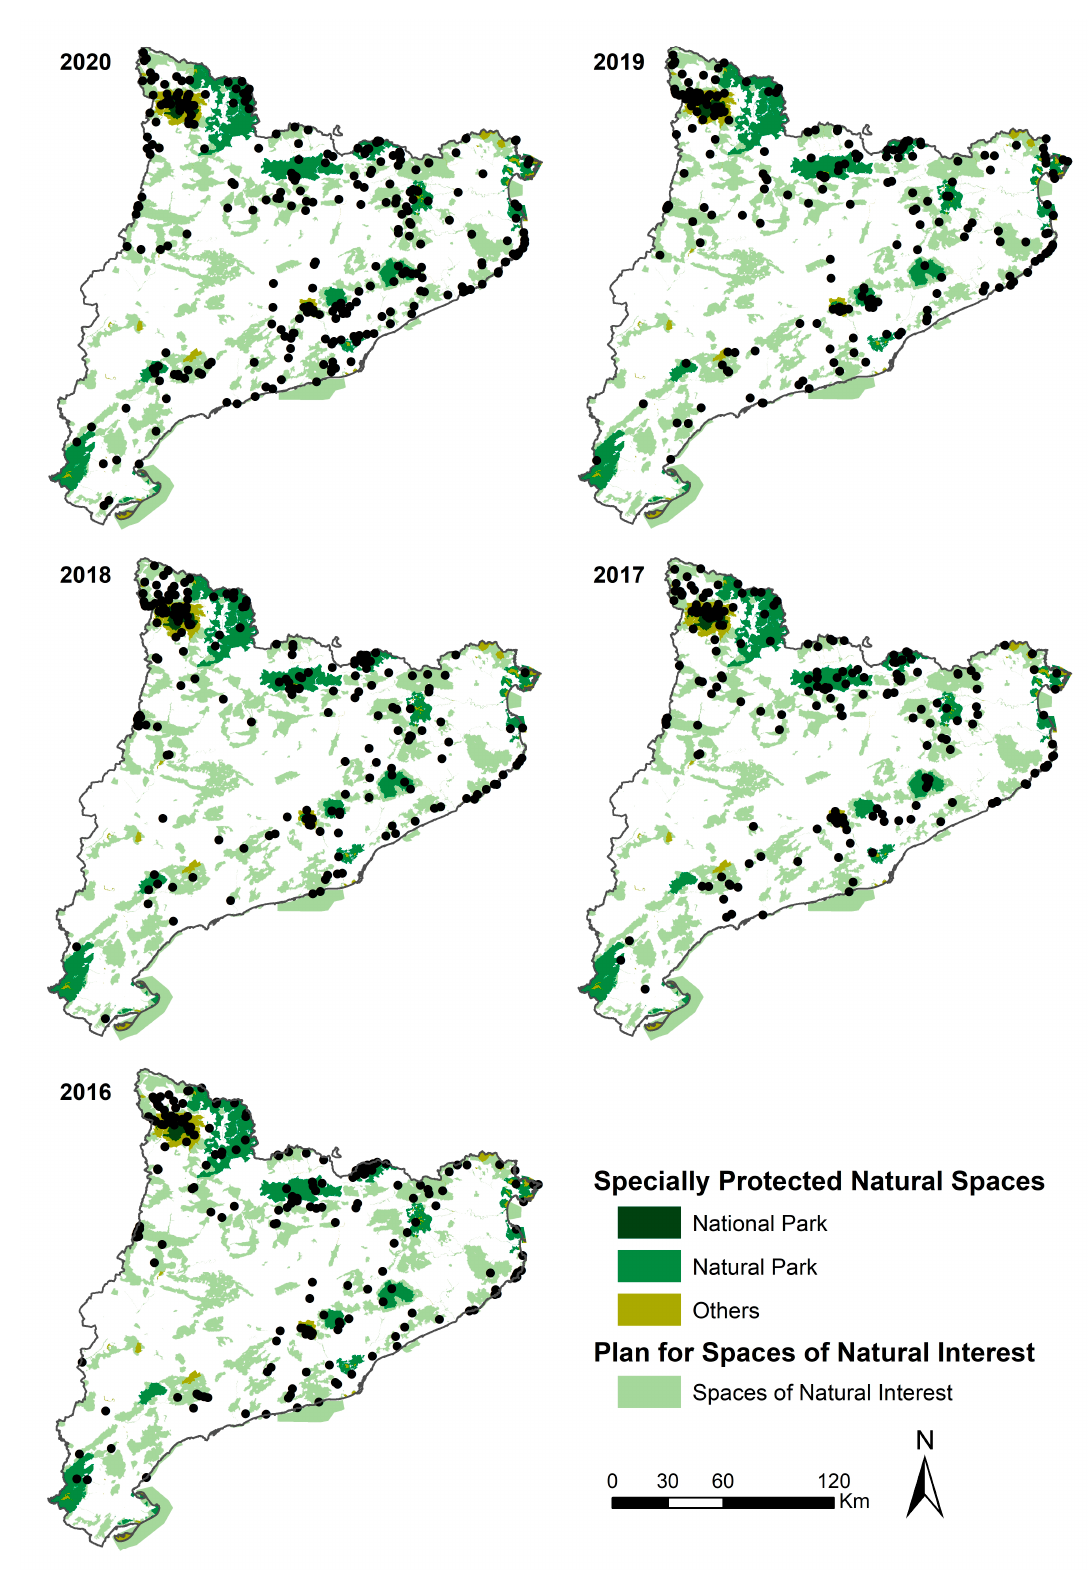
Figure 6. Spatial distribution of rescues and protection status.